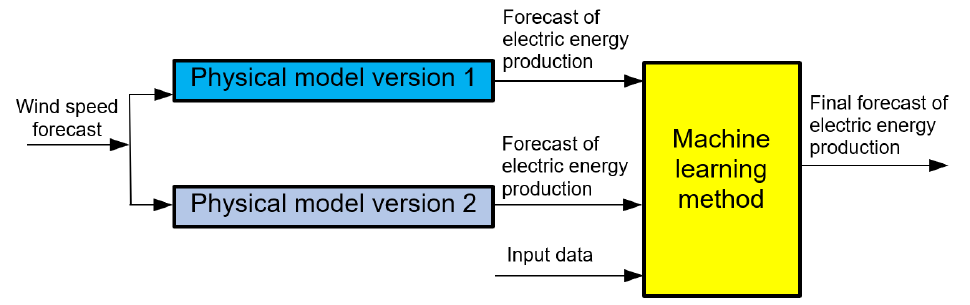
Figure 15. General structure of hybrid method—machine learning method with additional input data from two Physical models.